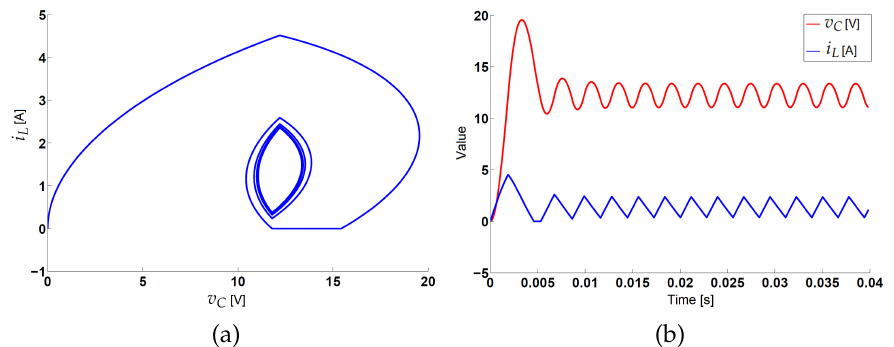
Figure 14. Voltage control using the constant hysteresis control for ξ = 0.2 V: ( a ) phase portrait and ( b ) time evolution.